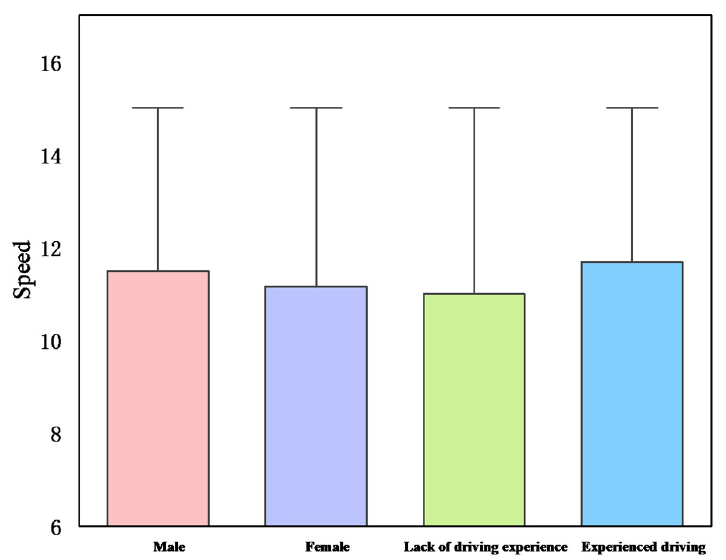
Fig 9. Effect of demographics on